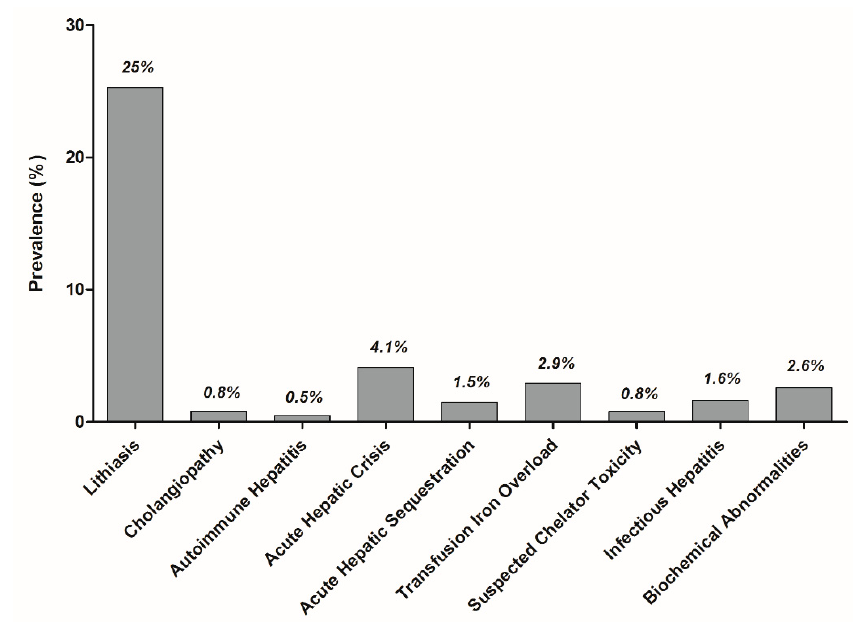
Figure 2. Prevalence of hepatobiliary complications in 616 children with sickle cell disease, followed up in our reference center from January 2008 to December 2017. “Acute hepatic crisis” includes acute sickle cell hepatic crisis and sickle cell intrahepatic cholestasis. Table 1. Clinical characteristics of patients with hepatobiliary complications.